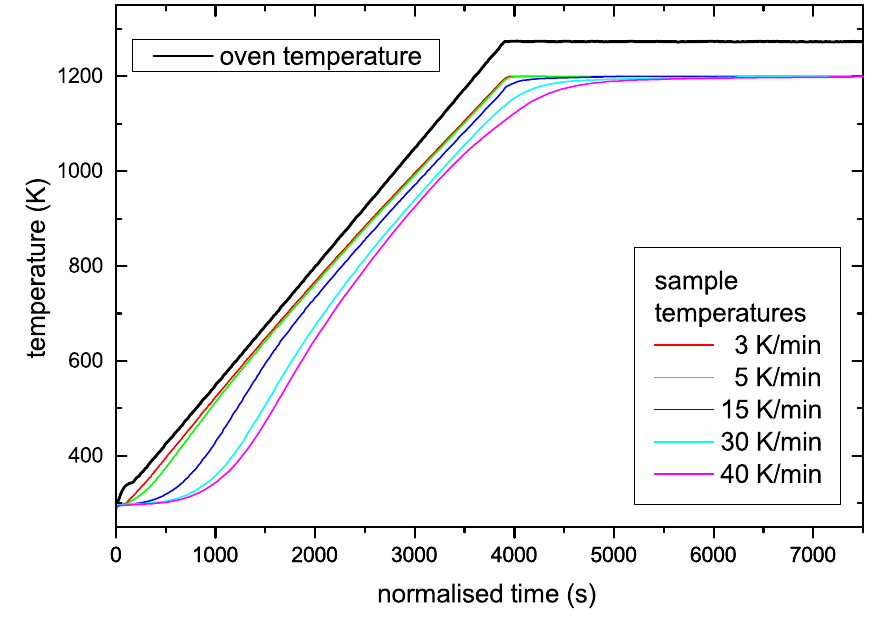
Figure 1. Calibration measurements for determination of the true sample temperature as a function of the oven temperature (thick black line). To allow easy comparison, the data are plotted on a normalized time scale. The time scale is the real time for the ramp with 15 K/min. The other time scales are compressed or expanded according to the actual nominal oven temperature ramp (e.g., the time scale for the ramp with 3 K/min is compressed by a factor of 5 while that for 30 K/min is expanded by a factor of 2). On this normalised time scale all oven temperature ramps